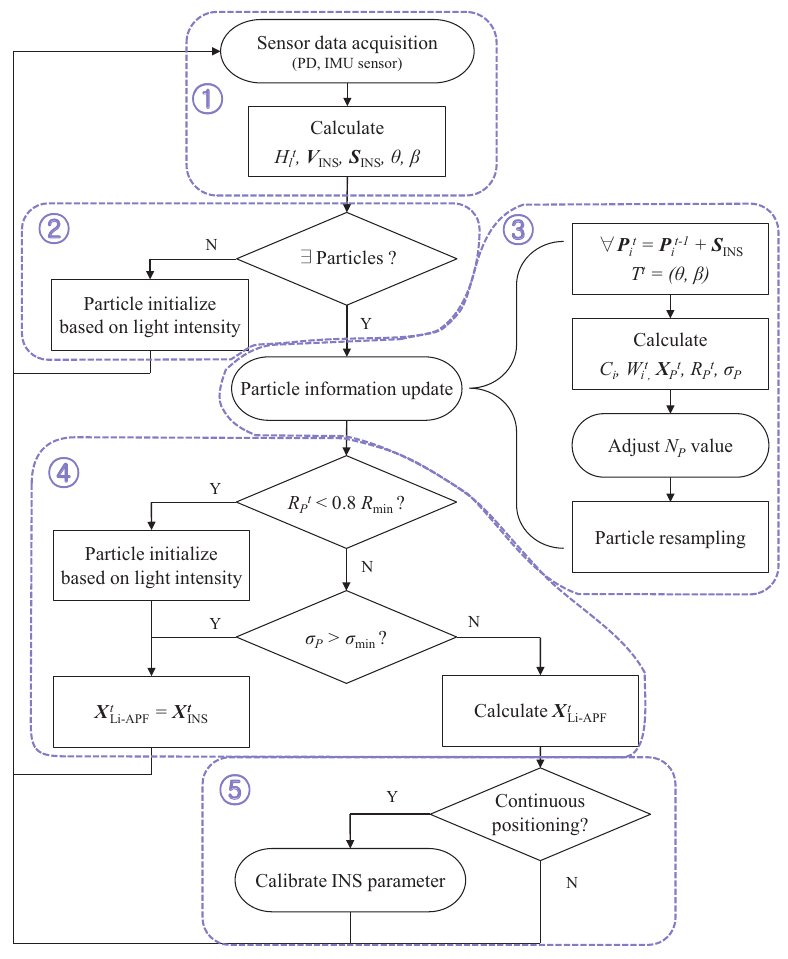
Figure 3. Overall flowchart of Li-APF